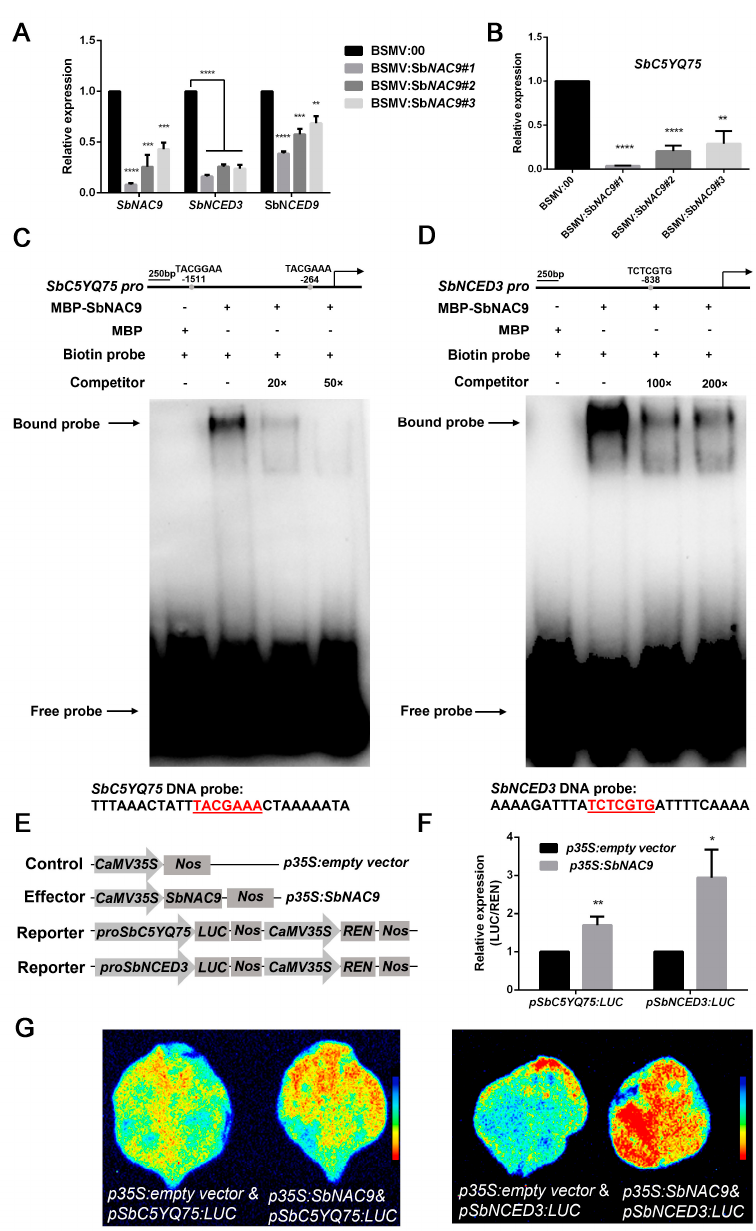
Figure 5. SbNAC9 directly activated the expression of SbC5YQ75 and SbNCED3 . ( A , B ) Relative transcript level of SbNAC9 , SbNCED3 , SbNCED9 ( A ), and C5YQ75 ( B ) in the third leaf of